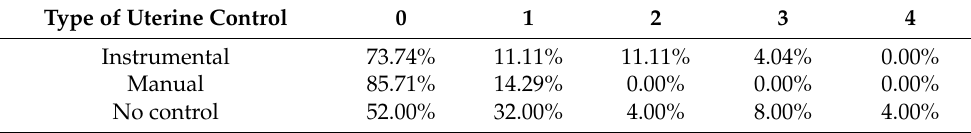
Table 18. The proportions of the PUUS values of patients regarding the type of uterine cavity control.